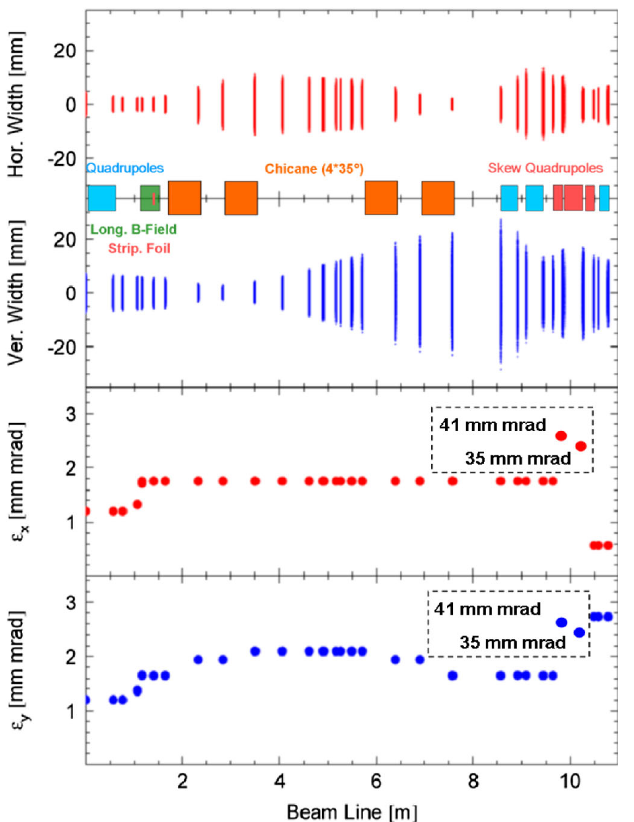
FIG. 12. Two-dimensional projections of the transverse phase space distribution at the exit of the longitudinal magnetic field section of the proposed emittance transfer section along the UNILAC. Horizontal and vertical rms Twiss parameters are indicated as well as the four interplane correlation